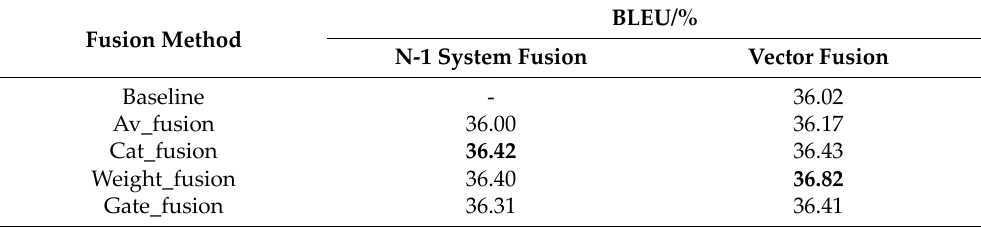
Table 2. BLEU value of comparative